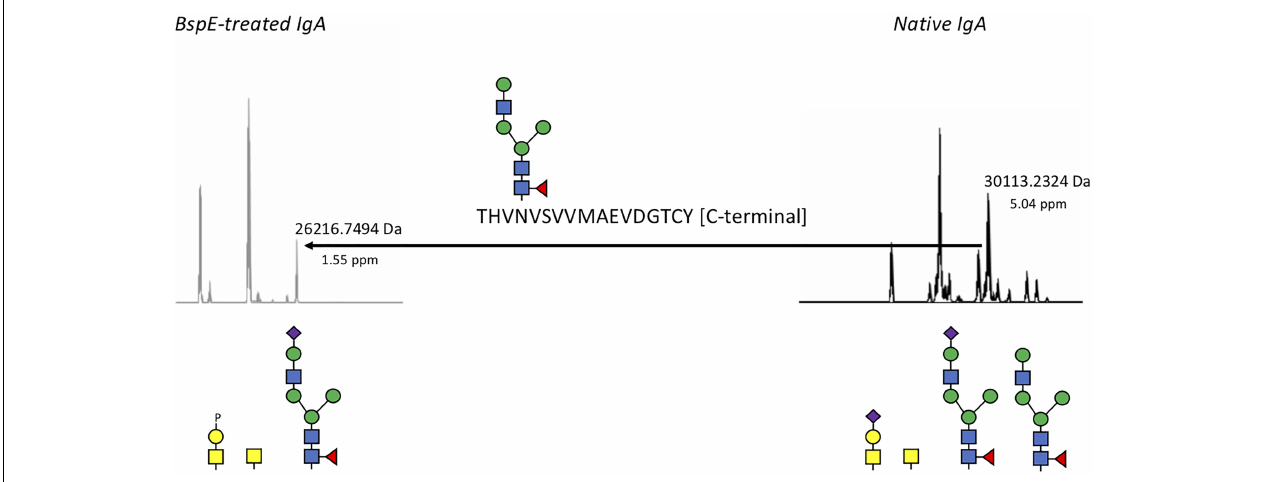
FIGURE 8 | BspE hydrolyses plasma IgA in the Fc-tail. Native and BspE-treated plasma IgA were hydrolyzed with a PPTP-protease to separate the heavy chain in two fragments. The hydrolysis fragments were reduced and analyzed by mass spectrometry for intact masses. Generated ions were deconvoluted and the most prevalent ions compared to each other. The Fc-heavy chain fragment of native IgA had a mass of 30113.2324 Da corresponding to the full-length IgA1 heavy chain hydrolyzed at the PP/TP-site in the hinge. A loss of a mass corresponding to a P/T hydrolysis in the C-terminal part of the Fc fragment in combination with an N-glycan resulted in the 26216.7494 Da fragment generated after BspE hydrolysis. Putative glycan structures based on mass are depicted below the ion spectra. Mass differences between theoretic and observed masses are depicted below the observed masses as ppm values.